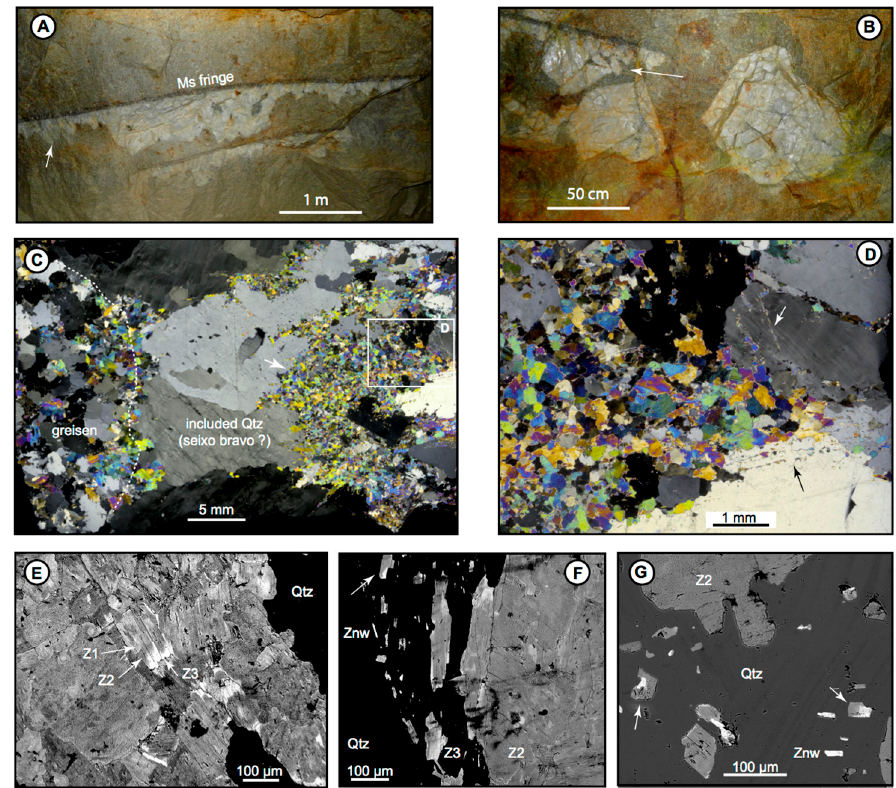
Figure 8. Quartz vein enclaves in the greisenised G4 granite from the greisen cupola (L2 level). ( A ) Photograph of dilacerated quartz vein enclaves; note the muscovite fringe and the euhedral quartz growing in the “greisen” matrix (arrow) (underground work, L2). ( B ) Idem; note the infiltration of the magmatic matrix into the vein (arrow). ( C ) Photomicrograph of a detail of the “greisen” contact to the included quartz (cross-polarized light, sample PNQ-21a). Insert shows the location of ( D ). Note the plastic deformation in the included quartz (seixo bravo?); the superimposition of the “greisen” to quartz enclave boundary; and the development of muscovite (“episyenite”) within the included quartz. ( D ) Detail of ( C ). Note the trails of tiny muscovite flakes into the deformed quartz (arrows). ( E ) to ( G ) SEM-BSE images of the muscovite-quartz contact around the muscovite in ( D ). ( E ) Zoning in the muscovite: a succession of a clear core (Z1), a darker rim (Z2), making the bulk of the aggregate, and a sporadic bright fringe (Z3). ( F ) Start of a muscovite trail in the quartz. Note the presence of tiny zinnwaldite crystals (Znw), accompanying the small muscovite flakes, and that the latter is growing at the expense of Znw (arrow). ( G ) Halo of tiny Znw crystals (replaced by muscovite: arrows) around the main muscovite aggregate.